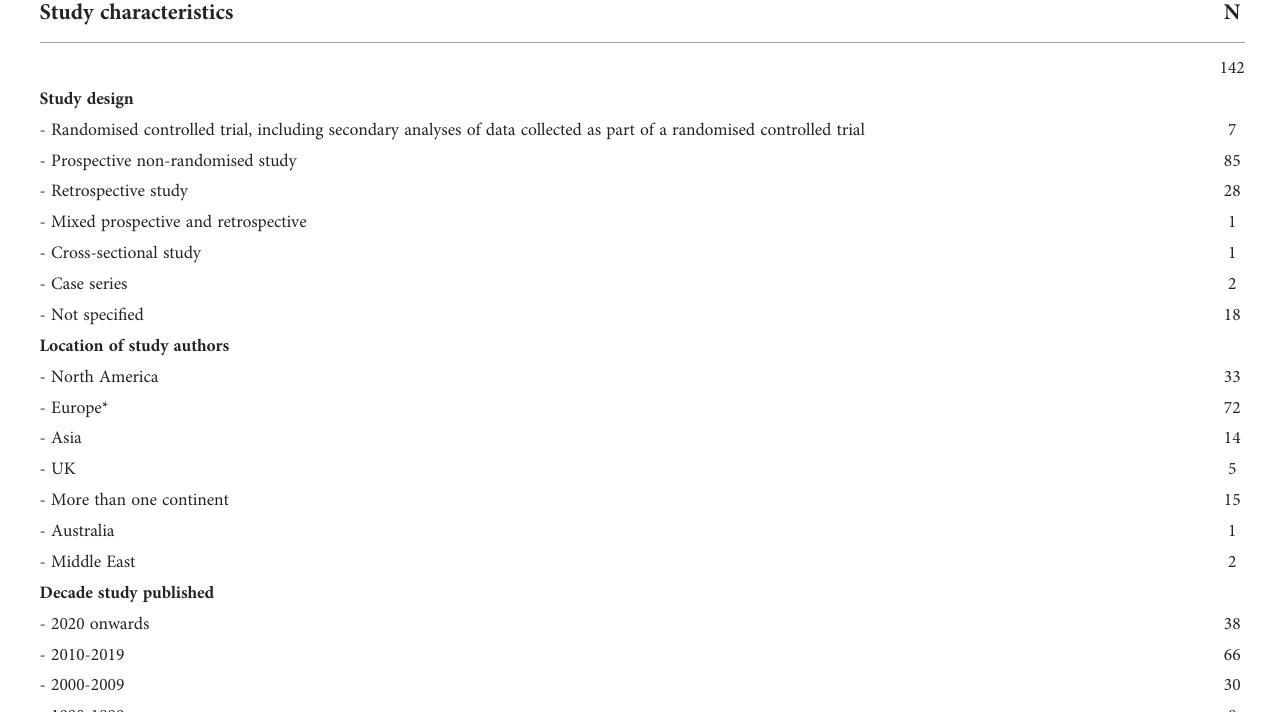
TABLE 1 Overview of the studies included in this systematic